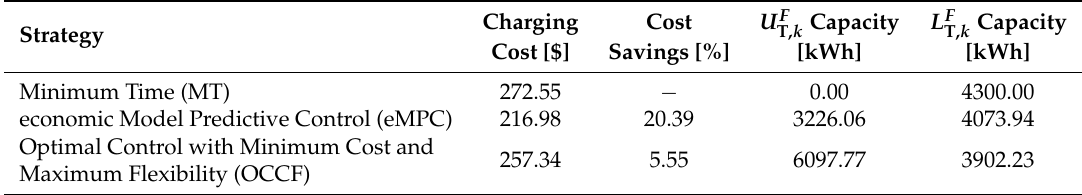
Table 4. Three strategies’ overall simulation results (three chargers, 11 EV requests)